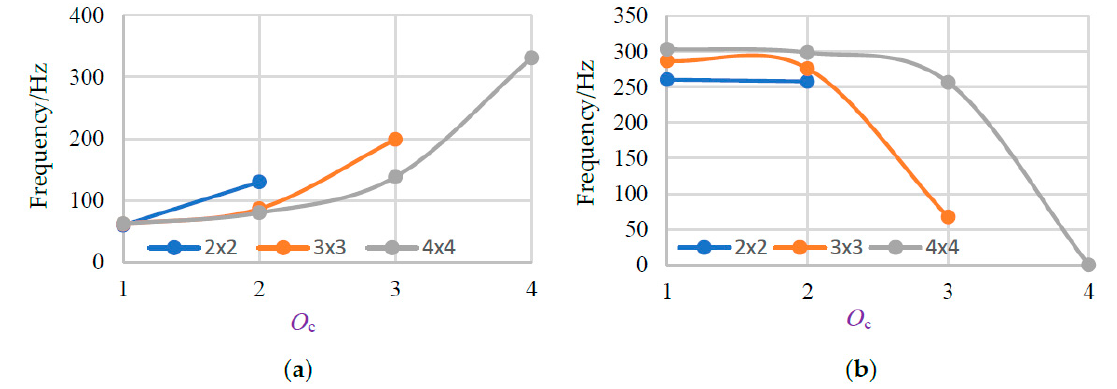
Figure 12. ( a ) The change rule of bandwidth for the third BGs with different O c . ( b ) The change rule of bandwidth for the fourth BGs with different O c .